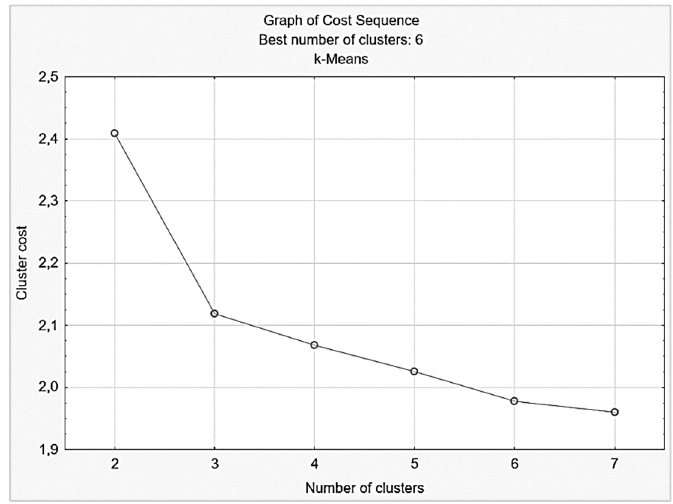
Figure 2. Graph of cost sequence. Source: authors’ work using Statistica Software.